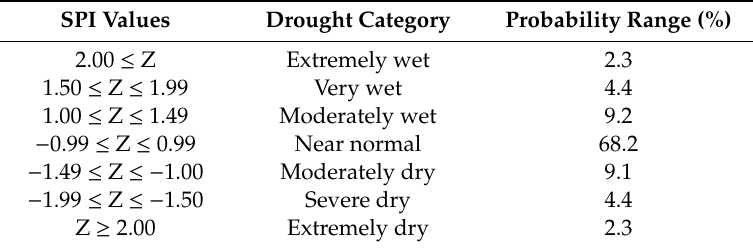
Table 3. Classification of drought severity for the range of index values